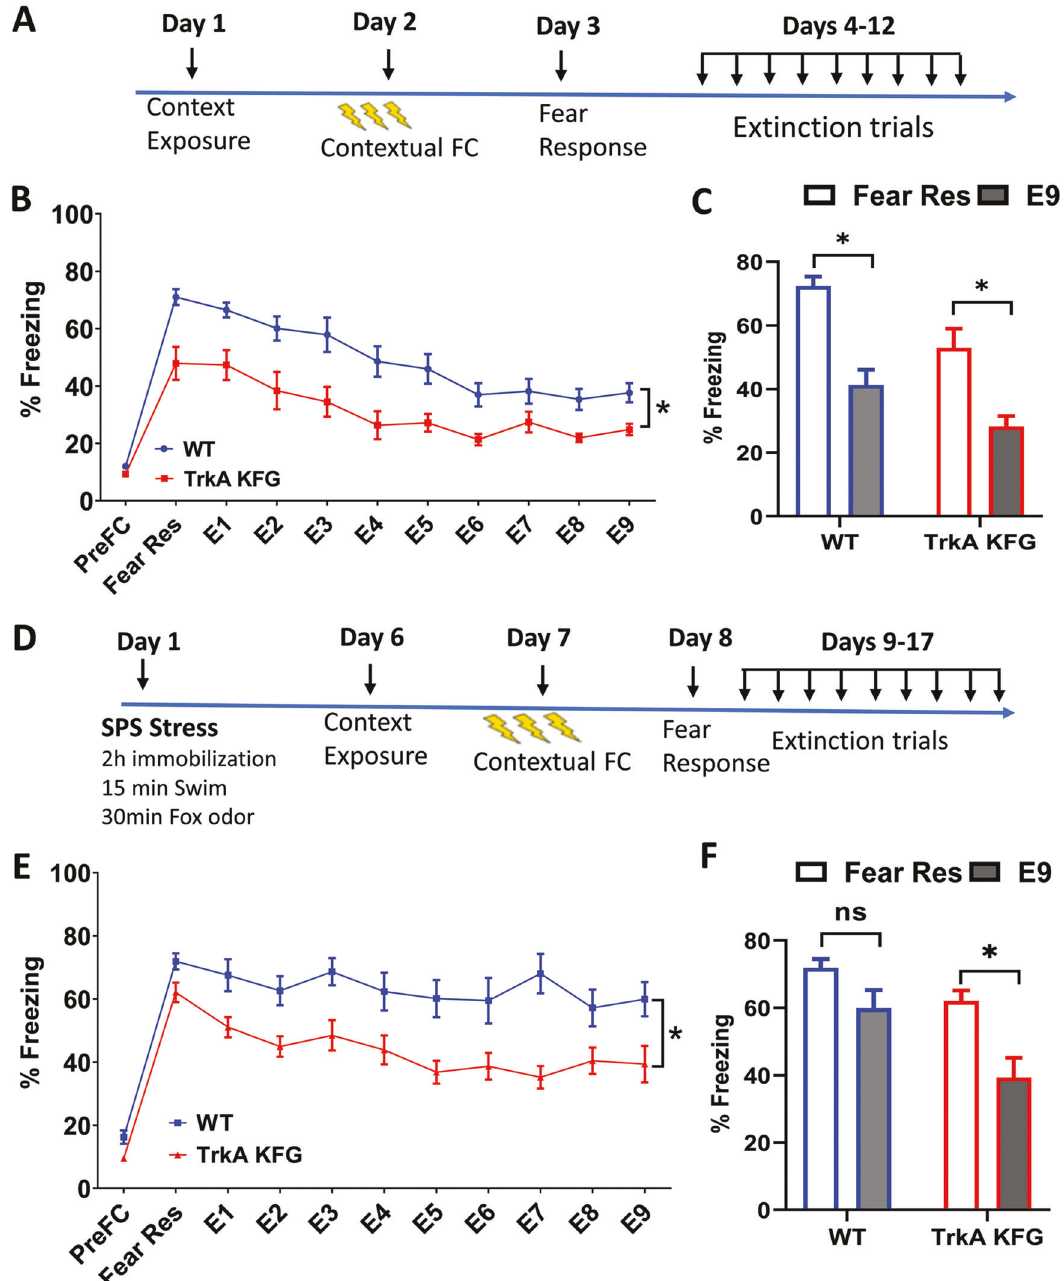
Fig. 3 TrkA-KFG mice show attenuated freezing behavior in contextual fear conditioning and extinction. A Schematic representation of the protocol used to test fear response and extinction after contextual conditioning. B Quanti fi cation of the freezing response after contextual conditioning shows a reduced expression of fear (Fear Res as in day 3 in A ) by TrkA-KFG mice (% Freezing 72.43 ± 2.95 in WT and 53.04 ± 5.98 in TrkA-KFG) that is maintained over the course of 9 extinction trials (E1 – E9 day 4 – 12 in A ) compared to WT mice. N = 13 for WT and 12 for TrkA-KFG mutants. C Graphical representation of the difference in freezing response measured as difference between the original fear response and last extinction trial (Points Fear Res vs E9 in panel B ). Note that both WT and TrkA KFG mice show signi fi cant, but similar reduction in fear response at the end of the extinction trials (% Freezing 72.43 ± 2.95 vs 41.33 ± 4.79 in WT mice and 53.04 ± 5.98 vs 28.33 ± 3.23 in TrkA-KFG mice. Data are the Mean ± SEM, p < 0.05 Mann – Whitney Test). D Schematic representation of the protocol used to test the fear response and extinction in the SPS stress model. E In the SPS model of PTSD-like behavior, 6 days after stress, the mice were subjected to fear conditioning and extinction protocol as in C . Similarly to the results obtained with non-stressed animals in B , TrkA-KFG mice show attenuated fear response and reduced freezing during the extinction trials when compared to control mice. % Freezing at each timepoint was analyzed by Mann – Whitney Test. * p < 0.05; n = 10 for WT and n = 11 for TrkA-KFG mice. F Graphical representation of the difference in freezing response between the original fear response and the last extinction trial (Points Fear Res vs E9 in panel E ) in WT (% freezing 71.92 ± 2.59 vs 59.99 ± 5.43, p > 0.05 n.s.) and TrkA KFG mice (% freezing response 62.08 ± 3.09 vs 39.39 ± 5.82, Data are the Mean ± SEM, p < 0.05 Mann – Whitney Test). Note that only the TrkA KFG mice show a signi fi cant reduction in fear response during the extinction